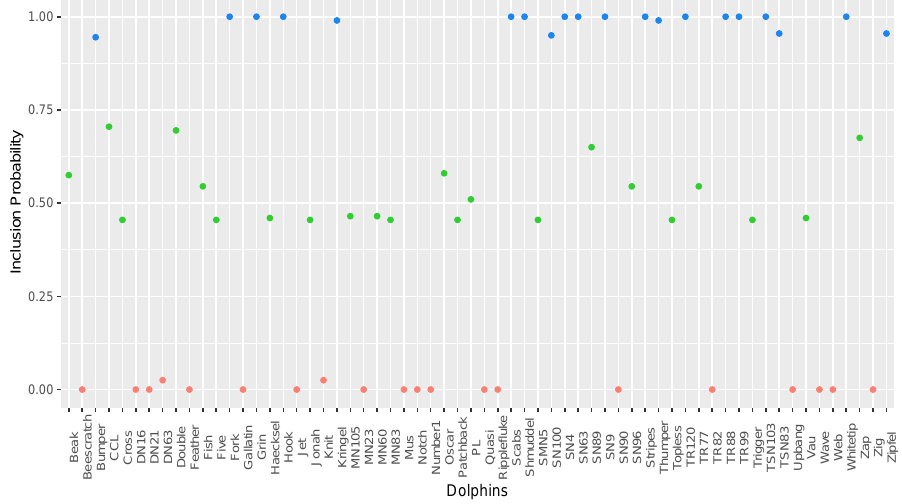
Figure 9. Inclusion probabilities in the local community of dolphin Grin. Colors represent three clusters of